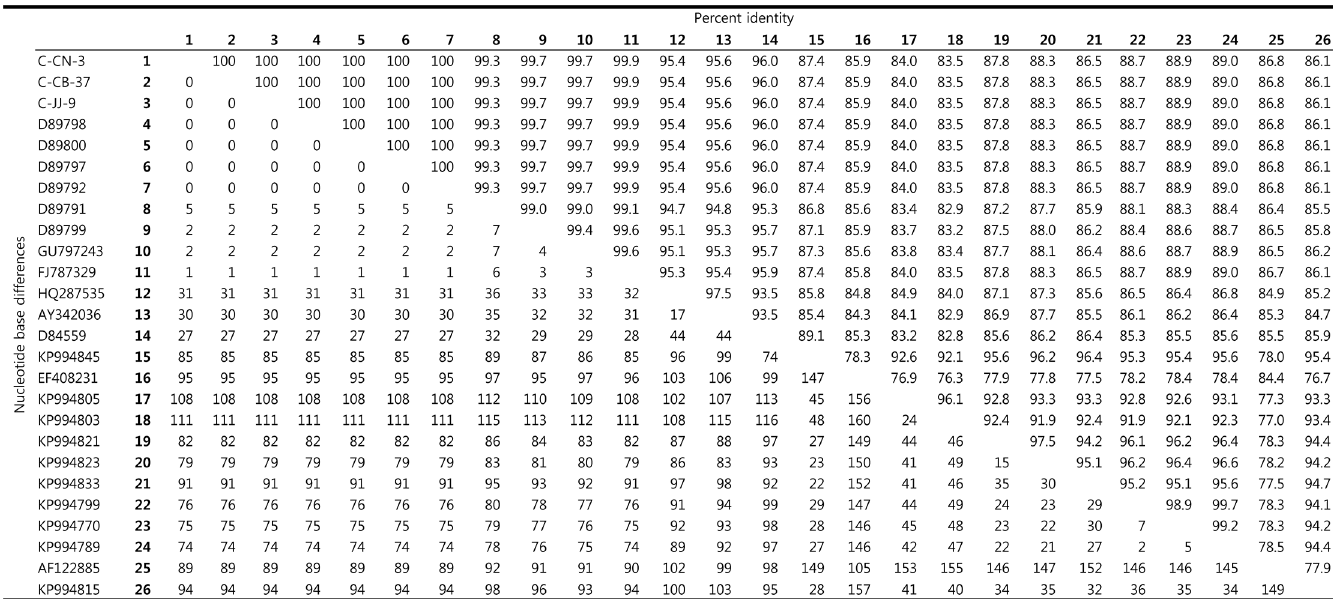
sequences for the 16S rRNA from the three samples (C-CN-3 from southern region, C-JJ-9 from Jeju Island, and C-CB-37 from central region) and from 23 bacterial species listed in GenBank. The three C . burnetii 16S rRNA sequences (accession nos. KT-835662, KU291428, and KU291429) showed 100% identity to each other and all were deposited in GenBank. The sequences also showed significant identity (99.3–100%) to eight additional C . burnetii isolates, which were also deposited in GenBank (Fig 2).